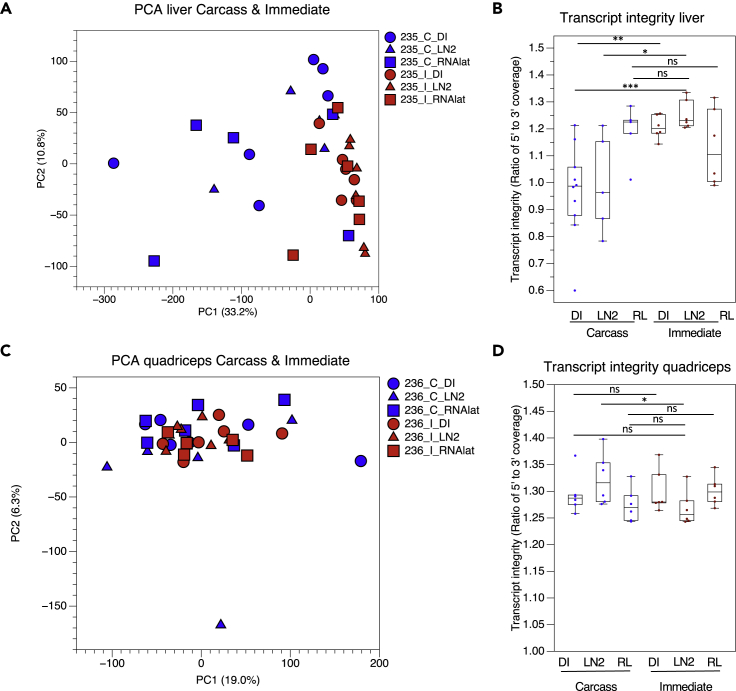
Gene Expression and Transcript Integrity Analysis of Preservation Methods for Liver and Quadriceps SamplesLiver and quadriceps samples were dissected from mice immediately after euthanasia with pentobarbital/phenytoin (Euthasol) then preserved in dry ice (I_DI), liquid nitrogen (I_LN2), or RNAlater (I_RNAlat) before RNAseq analysis. Alternatively, liver and quadriceps samples were dissected from partially thawed frozen carcasses of mice that were euthanized with pentobarbital/phenytoin (Euthasol) and then preserved in dry ice (C_DI), liquid nitrogen (C_LN2), or segmented into thirds and preserved in RNAlater (C_RNAlat) before RNAseq analysis.(A) Principal component analysis of liver samples. Percent variance for each principal component (PC) is shown.(B) Uniformity of gene body coverage in liver samples.(C) Principal component analysis of quadriceps samples. Percent variance for each principal component (PC) is shown.(D) Uniformity of gene body coverage in quadriceps samples. (∗∗∗ = p < 0.001, ∗∗ = p < 0.01, ∗ = p < 0.05, ns = no significance, Mann–Whitney U test). Data are from GLDS-235 (liver) and -236 (quadriceps).